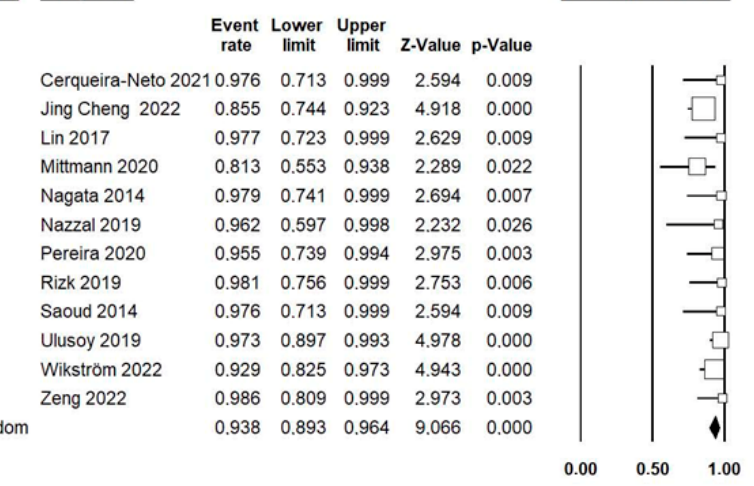
Figure 2. Forest plot of the estimated survival rate of traumatized teeth treated with pulpal revascu-